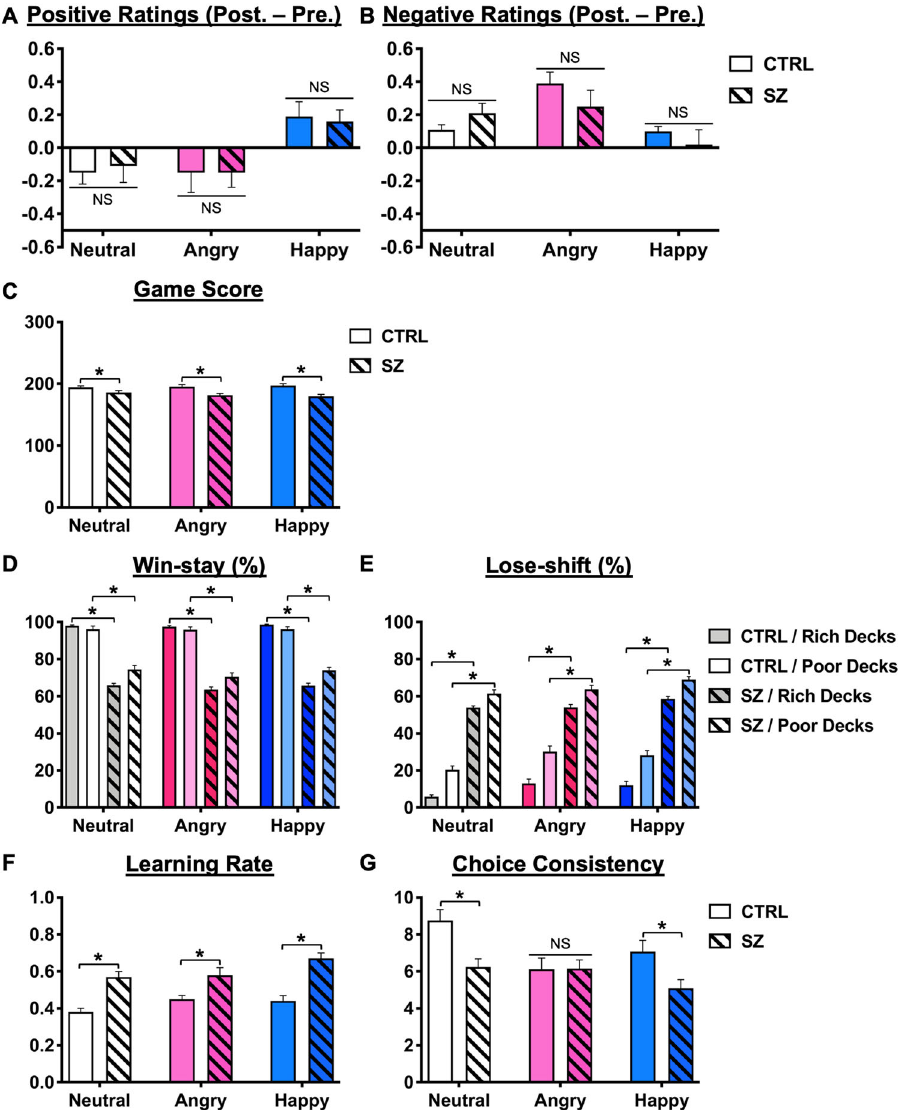
Fig. 1 Behavioral and model- fi tting results. A , B Difference between pretest and posttest mean (±SEM) rating scores of the positive-affect and negative-affect subscales from PANAS, respectively. Mean difference scores of the healthy controls (CTRL, open bars) and patients with schizophrenia (SZ, striped bars) groups in the neutral (bars in white/gray), angry (bars in pink/light pink), and happy (bars in blue/light blue) facial prime conditions are shown. C Mean (±SEM) game scores. D , E Mean (±SEM) percentage of win-stay and lose-shift. The results of rich and poor decks are illustrated in black and gray lines, respectively. F , G Mean (±SEM) learning rate and choice consistency, respectively. * p < 0.05 between CTRL and SZ groups in the facial prime